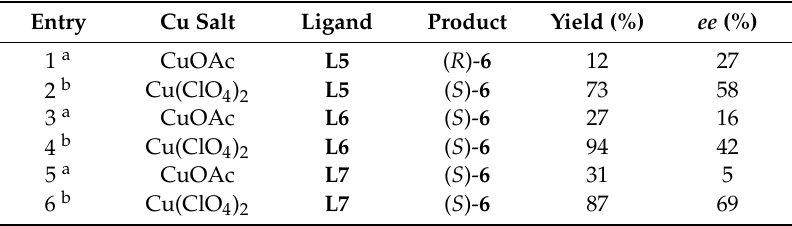
Table 9. Effect of chiral ligand structure on switching of stereoselectivity in the conjugate addition reaction of 5 .